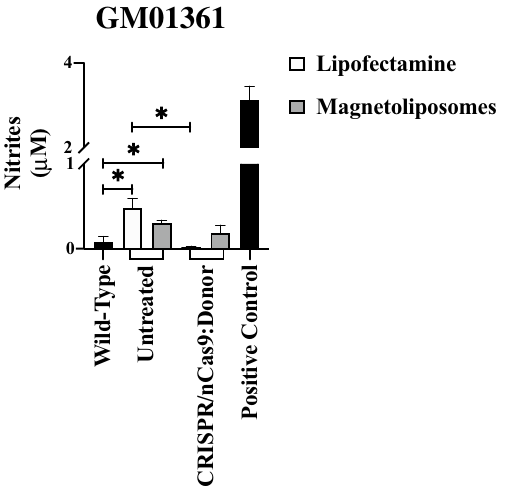
Figure 6. Effect of MLPs-attached CRISPR/nCas9 on the global profile of NO-derived species in MPS IVA fibroblasts. Mean of 4 experiments for GM01361 fibroblasts after transfection with CRISPR/nCas9-Donor AAVS1:GALNS plasmids (CRISPR/nCas9:Donor) using LP and MLPs as the delivery system. Note that untreated cells showed a significant increase in nitrites amounts compared to wild-type. LPS was used as positive control on wild-type cells. *p ≤ 0.05 . Two-tailed Student’s